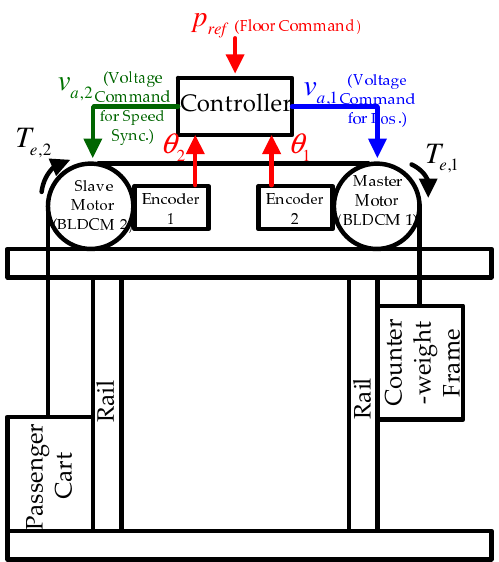
Figure 1. Hardware and software configuration of dual-motor elevator